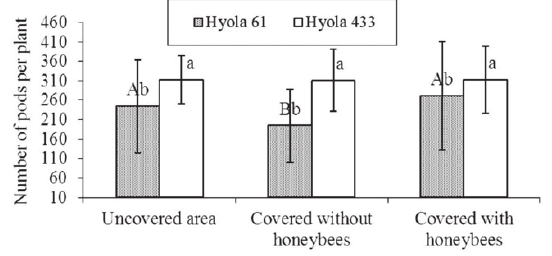
Fig. 4 - Number of pods per plant for each pollination test and hybrid regardless of the sowing date. Columns followed by different lowercase letters differ between hybrids for each pollination test according to the F -test ( P < 0.05). Columns followed by different uppercase letters differ between pollination tests for each hybrid according to the Student- Newman-Keuls test (P <